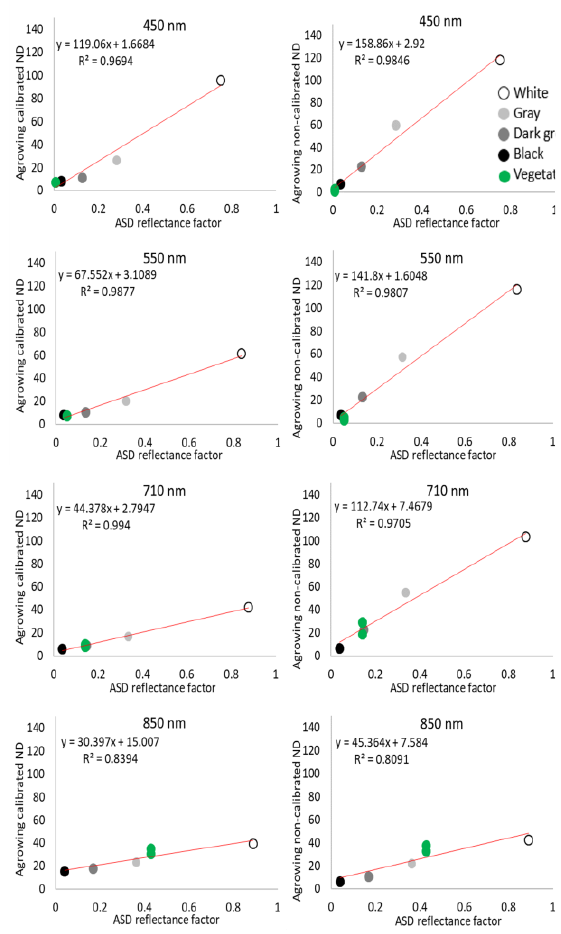
Figure 10. Scatterplots and adjusted lines between the ASD reflectance and Agrowing calibrated and non-calibrated digital number, for 3:30 pm acquisition.